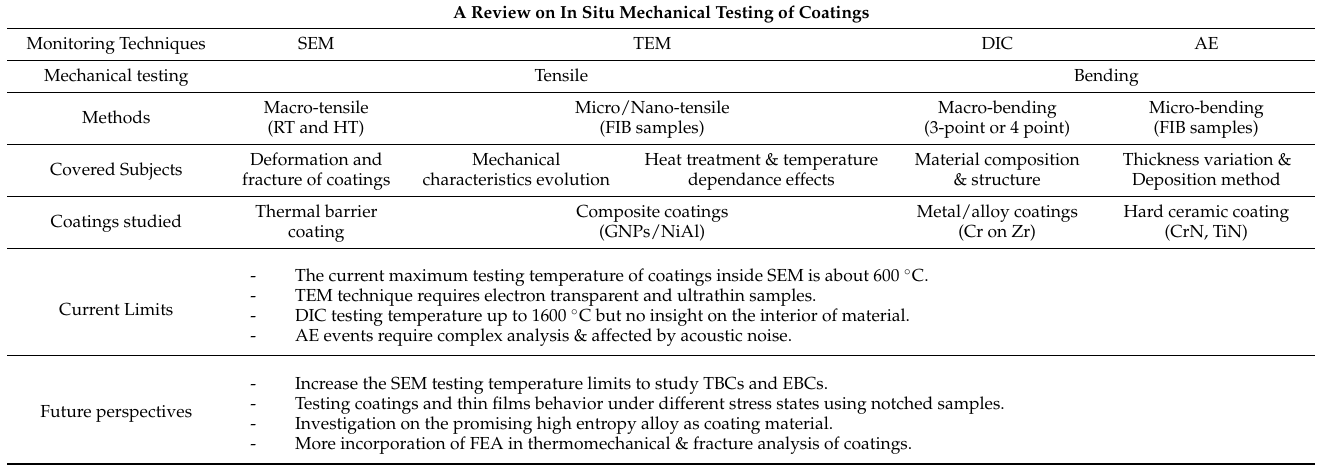
Table 1. Summary of the current research